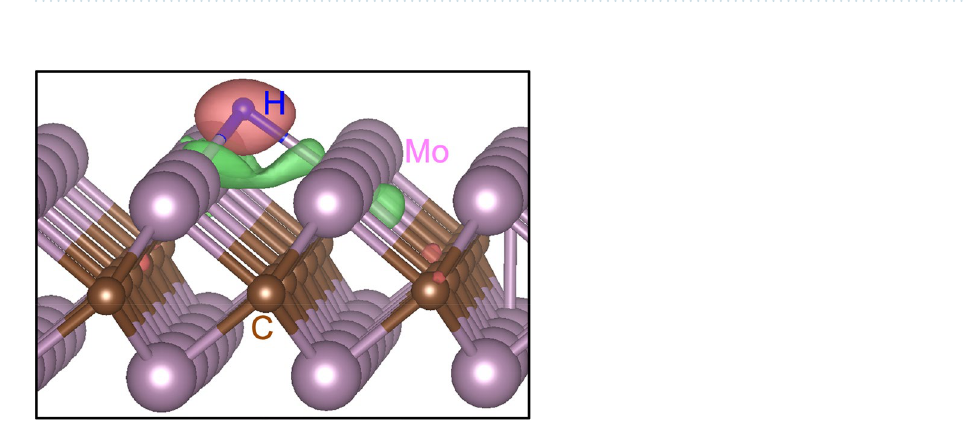
Table 1. The effective charge of the Mo and H atoms in the isolated Mo 2 C and Mo 2 C on Ag (Mo 2 C/Ag), Cu (Mo 2 C/Cu), and Au (Mo 2 C/Au) substrates obtained from Bader charge analysis. The numbers in parentheses are the number of valence electrons on the corresponding atom. The second column shows the charges and number of valence electrons of the Mo atoms before H absorption, and the third and fourth columns are the values for the Mo atoms that are the nearest neighbors of the H atom and H atom, respectively, after H absorption.